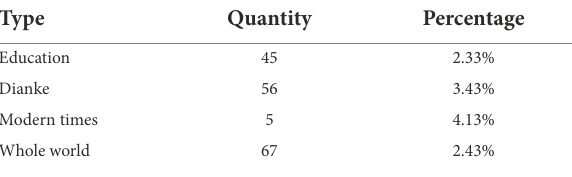
TABLE 1 Data sheet of deep learning research.